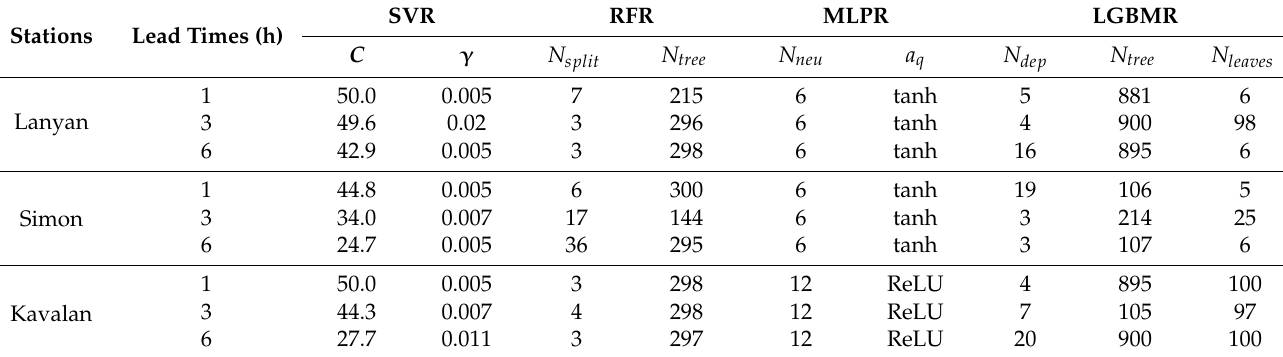
Table 6. The hyperparameters results of four models for 1–6-h lead times at three